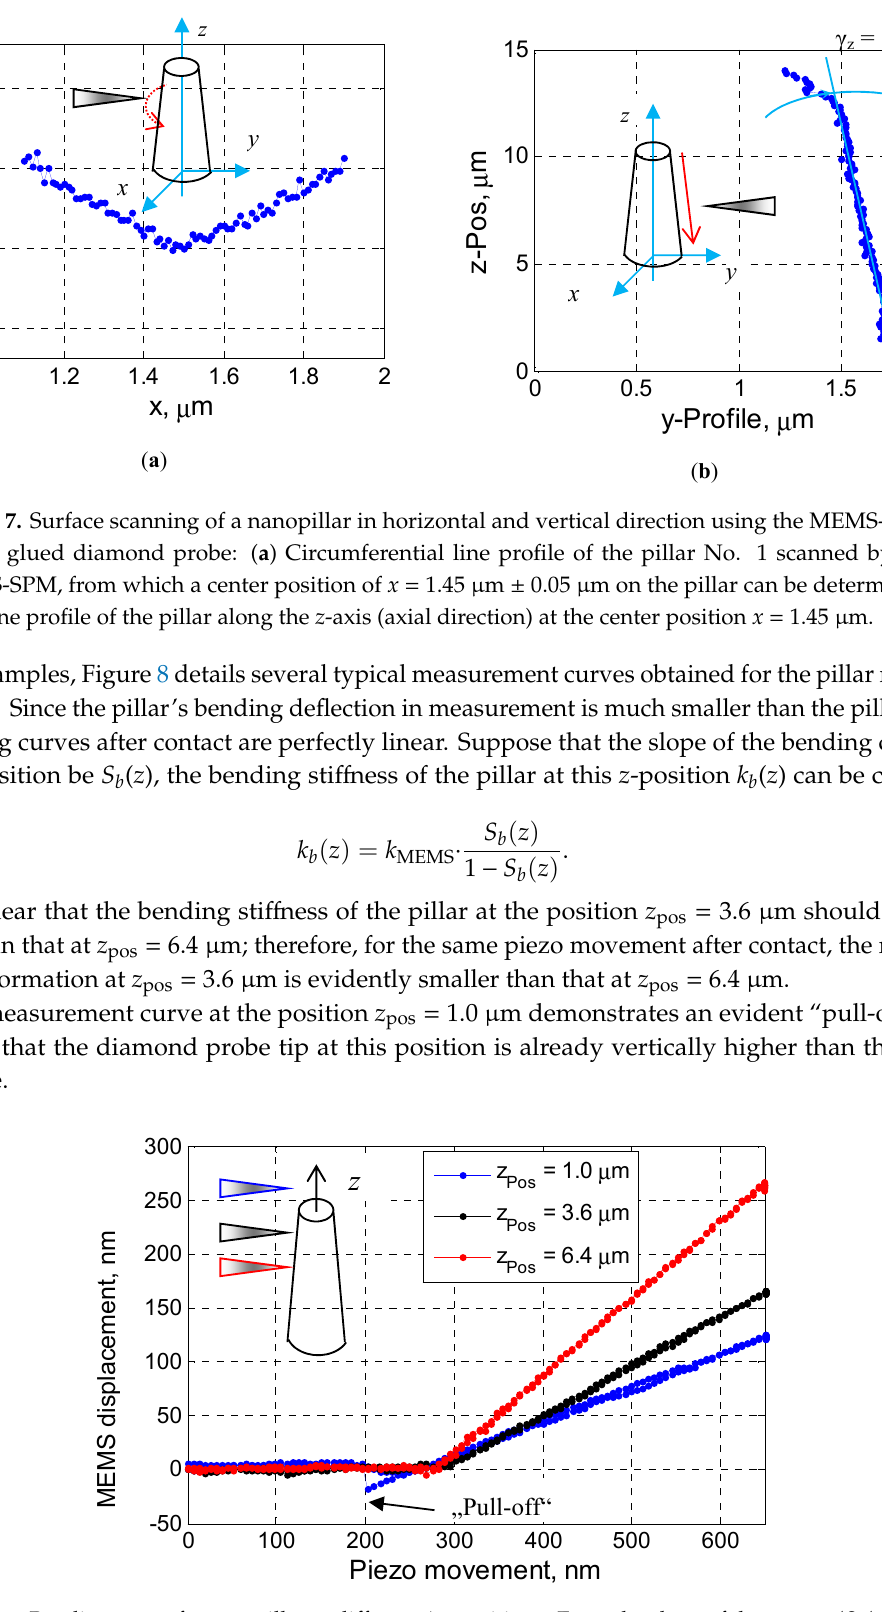
bending sti ff ness of the pillars k b ( z ) can be the bending stiffness of the pillars k b (z) can be determined.